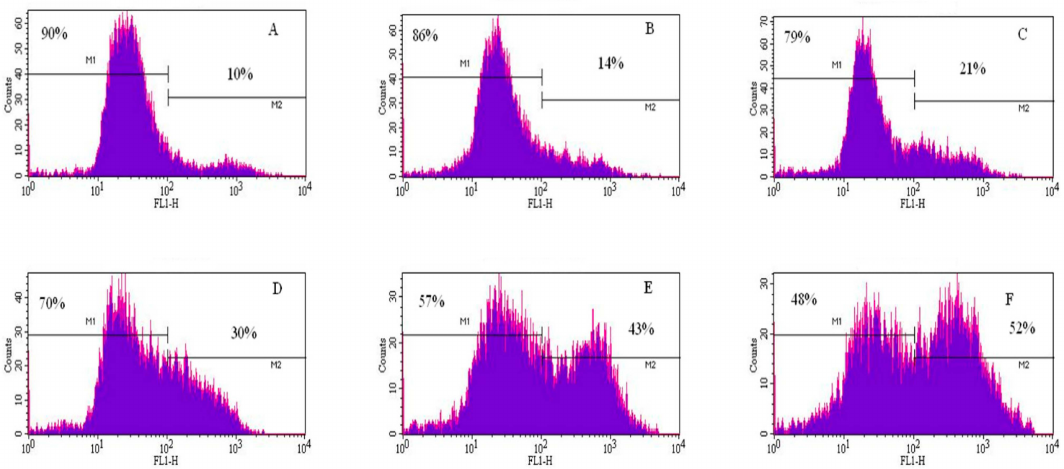
Figure 5. Representative flow cytometry analysis data from annexin V/PI assay. The histograms show a comparison of the distribution of annexin V/PI negative cells (M1) and annexin V/PI positive cells (M2) after 48 h exposure to cadmium chloride. A = control; B = 1 µ g/mL; C = 2 µ g/mL; D = 3 µ g/mL; E = 4 µ g/mL; and F = 5 µ g/mL.